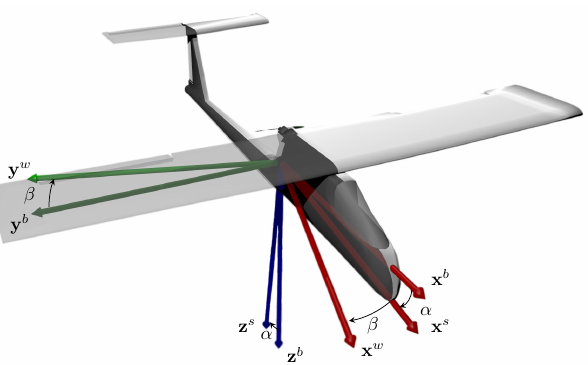
Figure 2: The relationships between the body, stability Figure2.1:Thebody,stabilityandwindframe.Byusingtheangleofatta kand and wind thesideslipangle,therelationbetweenthebodyframeandthedire tionofthe airspeedisobtained(illustrationbyTomStianAndersen).